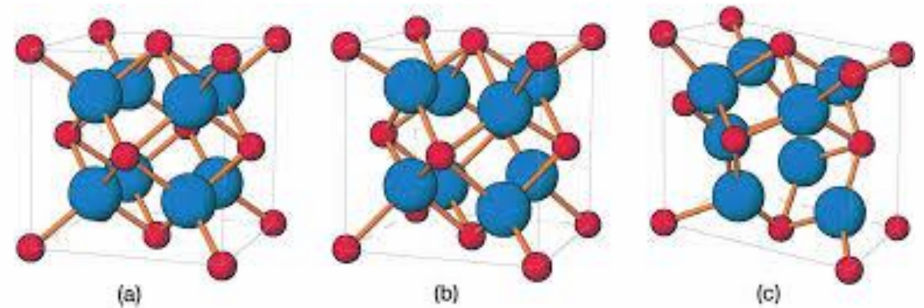
Figure 1. Scheme showing the 3 different atomic structures of ZrO 2 . Cubic ( a ); tetragonal ( b ) and monoclinic ( c ). Reprinted with permission from Wiley, reference